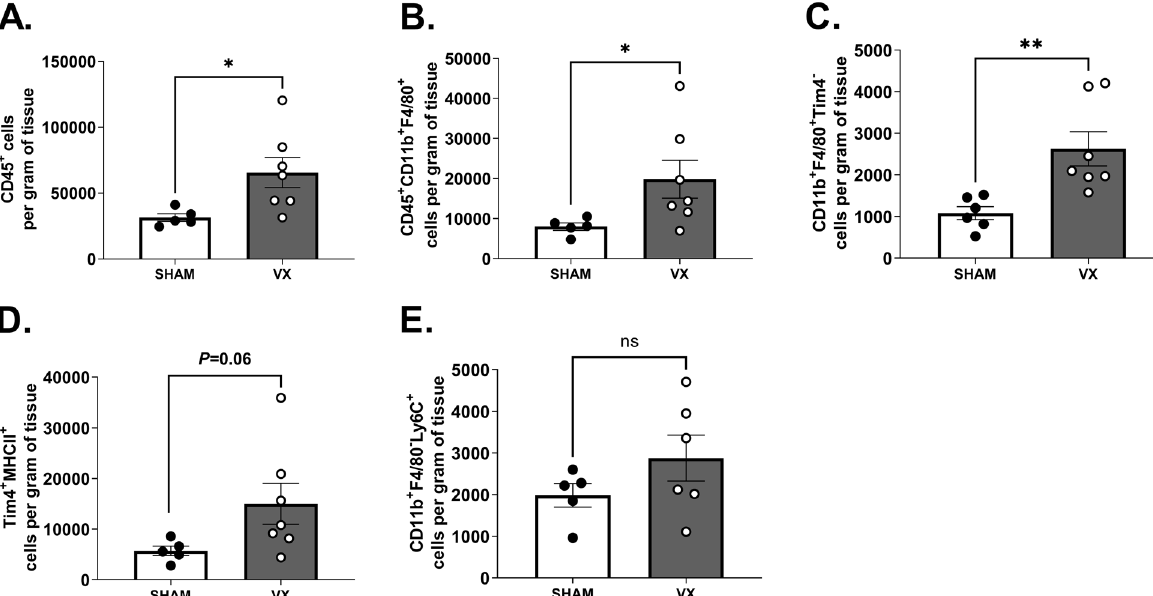
Fig. 1 Elevated peritonitis-induced liver leukocyte content in vagotomized mice. Wild-type C57BL/6 J mice were subjected to either left cervical unilateral vagotomy (VX, grey bars) or sham surgery (SHAM, white bars). After 7 days, mice were injected intraperitoneally with zymosan (0.1 mg/ mouse) and euthanized 12 h thereafter. Liver homogenates were analyzed by flow cytometry for ( A ) CD45 + , ( B ) CD45 + CD11b + F4/80 + , ( C ) CD45 + CD11b + F4/80 + Tim4 − , ( D ) CD45 + CD11b + F4/80 + Tim4 + MHCII + , and ( E ) CD45 + CD11b + F4/80 − Ly6C + cell subsets. Results were normalized to liver biopsy mass (g). n 6–7 per group. Results are expressed as mean SEM. ns not significant; * p < 0.05; ** p < 0.01 (two-sided Student´s t -test; = ± = Welch’s correction was applied as